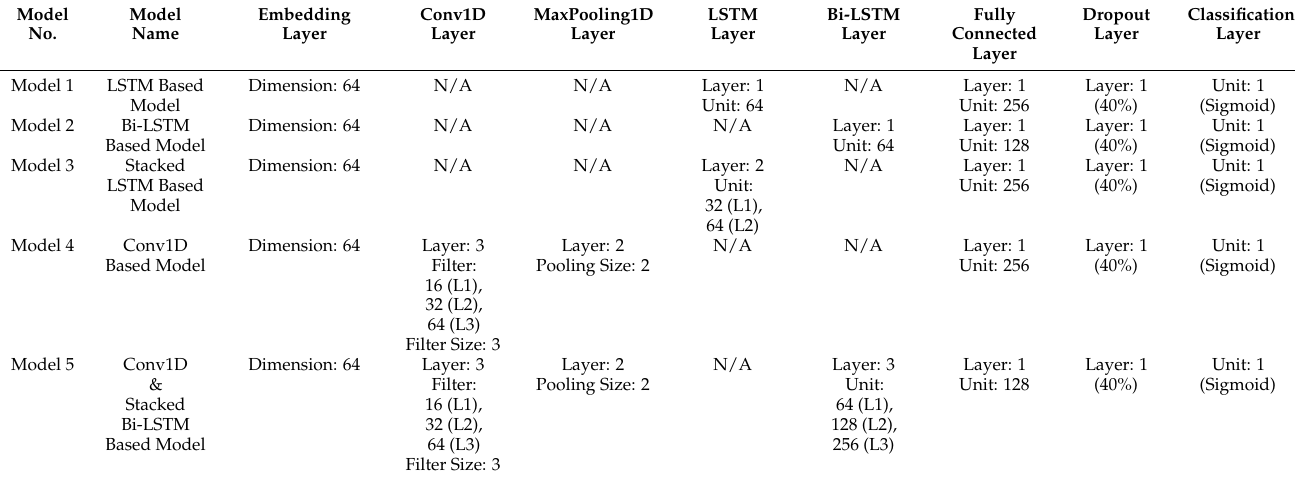
Table 2. Experimental setting of different DNN models.